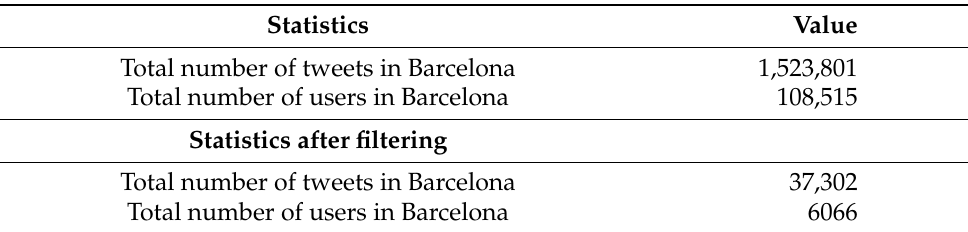
Table 3. Data set